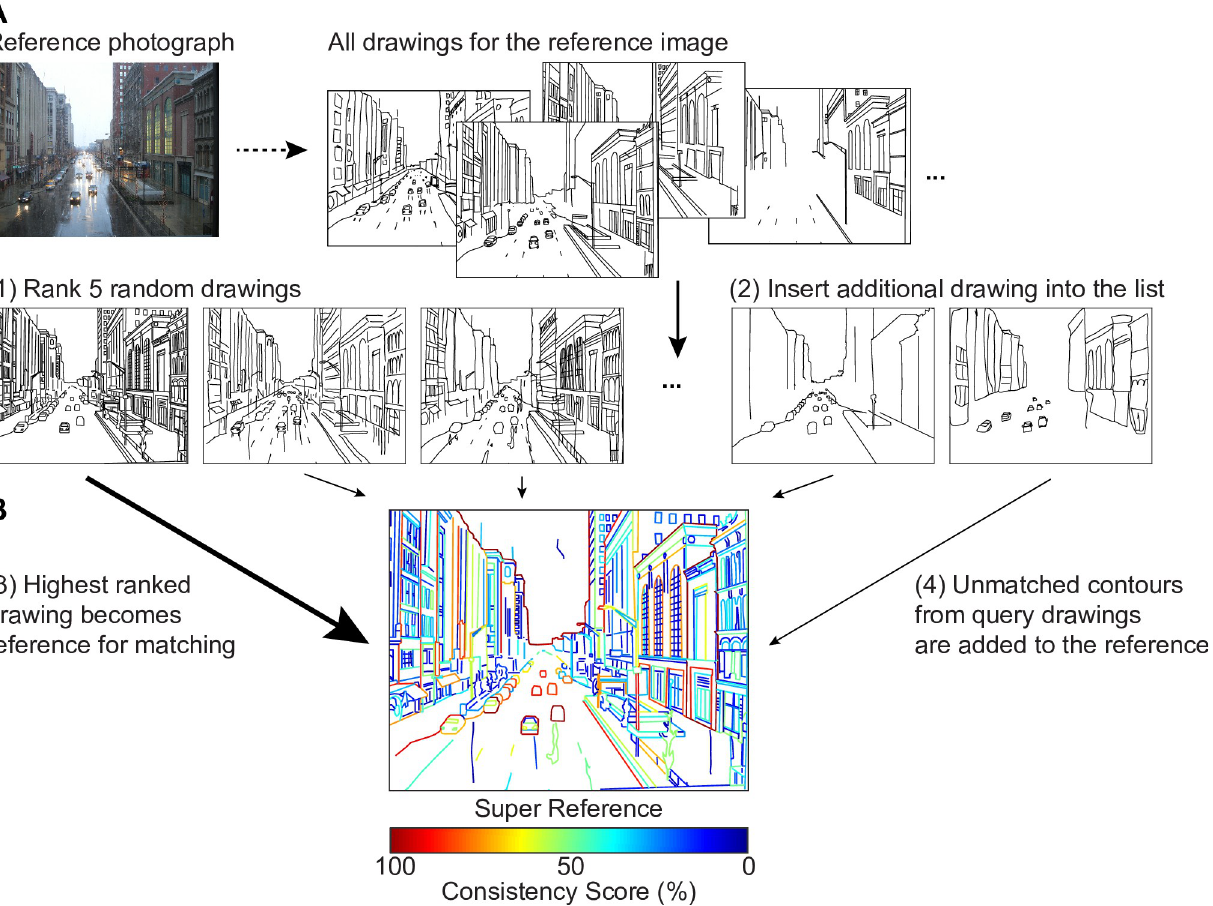
Fig 2. Procedures for Experiment 2. (A) Ranking of line drawings was performed by re-arranging images printed on cardstock on a large table. Participants were instructed to first rank five randomly chosen drawings, and to then insert subsequent drawings at the appropriate position. (B) Constructing a super-reference. The highest-ranked drawing served as the initial reference. The other drawings were matched to the reference in ranking orders. Unmatched contours were added to the reference, eventually yielding a super-reference that contains the super set of contours from all drawings. Original photograph under Creative Commons License by Flickr user Cyndy Sims